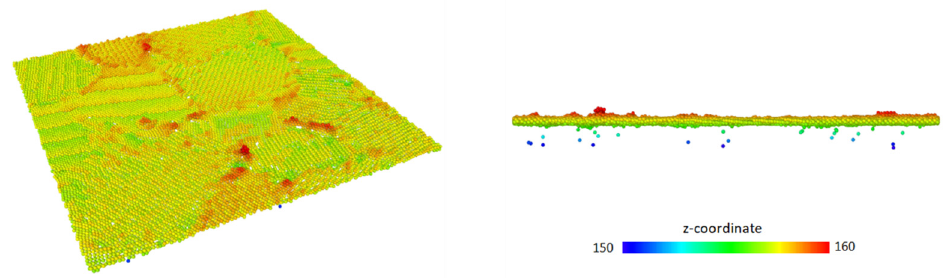
Figure 1. Perspective and 2D view of the resulting surface in the case of deformed geometry at 900 K. Atoms are color coded by the z-coordinate. A small number of low coordination false positives can be seen in the rightmost graph.